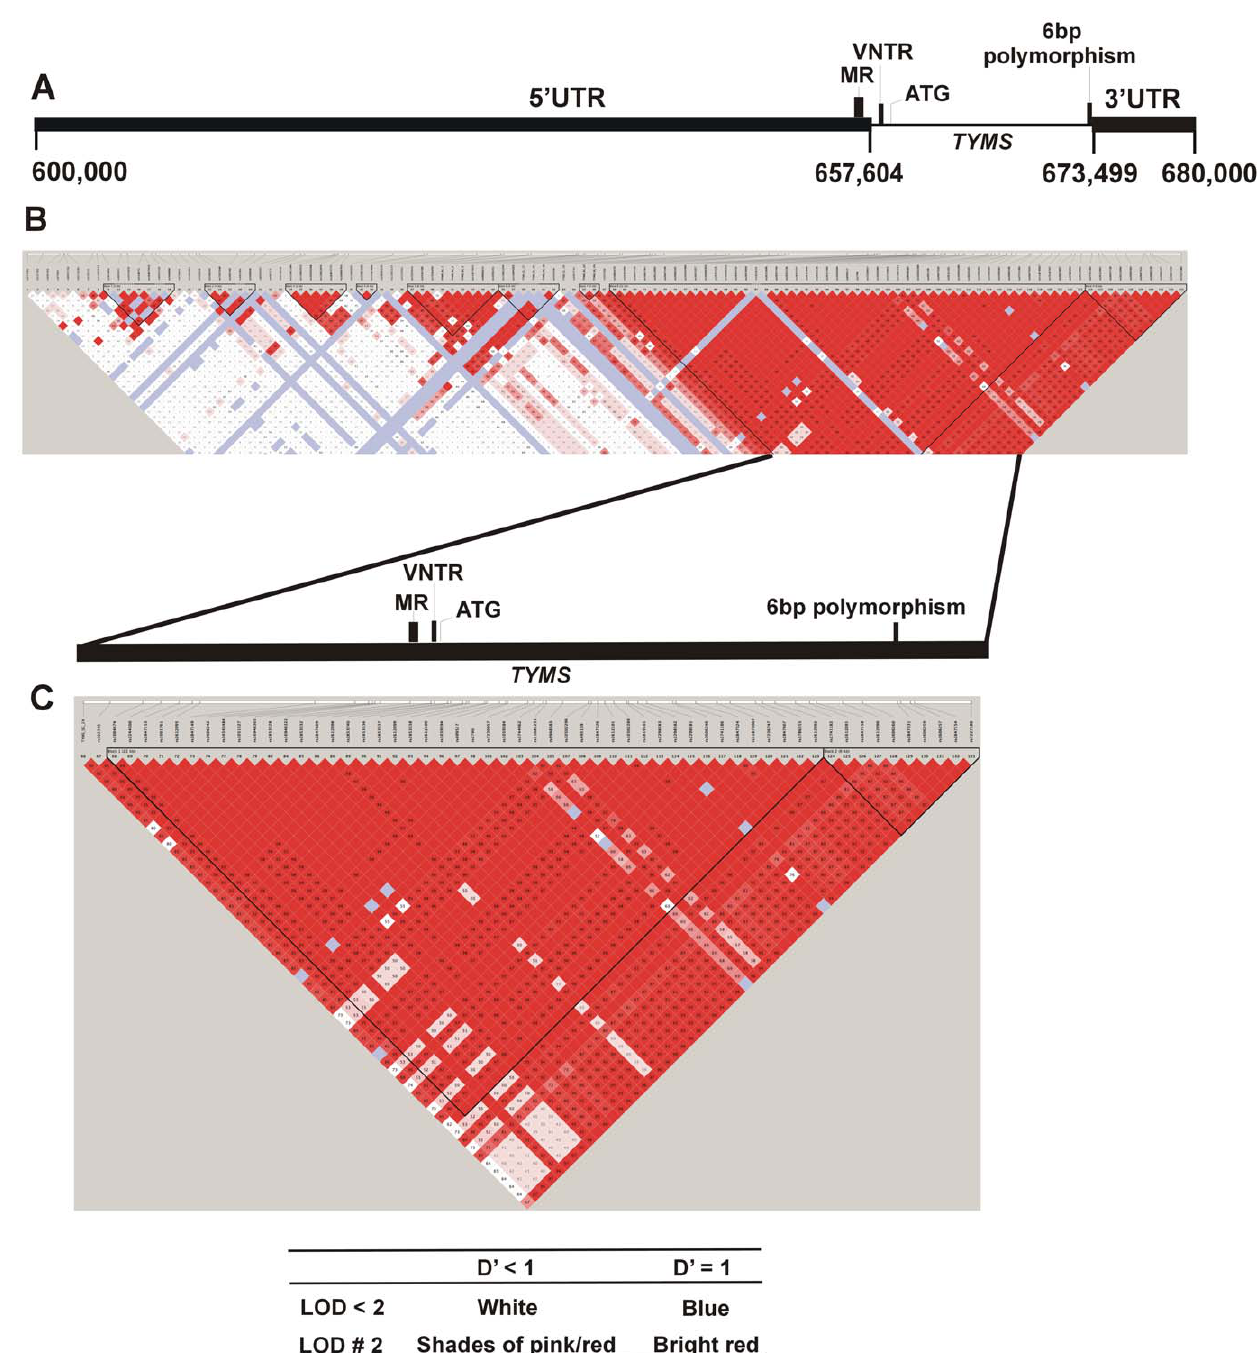
Figure 1. Haplotype structure of the TYMS genetic region. A. Linear map of the 80 kb TYMS genetic region covering the TYMS gene (coordinates 657,604–673,499), upstream region (600,000–657,603) and downstream region (673,500–680,000). All coordinate positions are according to UCSC genomic build GRCh37/hg19. SNPs along this region were selected from the HapMap database (see Materials and Methods) and from our sequence analysis. B. Nine haplotype blocks (in triangular shape), numbered 1 to 9, were obtained by haplotype analysis using Haploview (see Materials and Methods). The reference SNP numbers (rs) are indicated on top. The linkage disequilibrium (D 9 ) is indicated in the small boxes colored red or blue (a color legend is provided). Some newly discovered SNPs that were not in the public database at the time of analysis were named as TYMS_SG 1, 2, 3, 16,19, 22, and 24. At the time of submission of the new SNPs, we noticed they were deposited by others and had assigned SNP numbers of rs12964837, rs11872762, rs11877806, rs36124867, rs75363899, rs2853533, and rs72634355 respectively. C. The largest haplotype block spanning the TYMS gene and some parts in the 5 9 UTR, including the VNTR and the mononucleotide repeats, and the 3 9 UTR, is expanded. Blocks 1 and 2 in this figure corresponds to blocks 8 and 9 respectively, of Figure 1B. The unmatched marker 87 corresponding to SNP number rs3826626 (in panel B) was removed in this figure. The locations of the VNTR, MR (mononucleotide repeats), and the 6-bp deletion/insertion polymorphism are shown. The TYMS translational start codon is 13 bp downstream of the VNTR. Enlarged versions of figures B and C are provided in supporting information as figure S2 and figure S3, respectively.